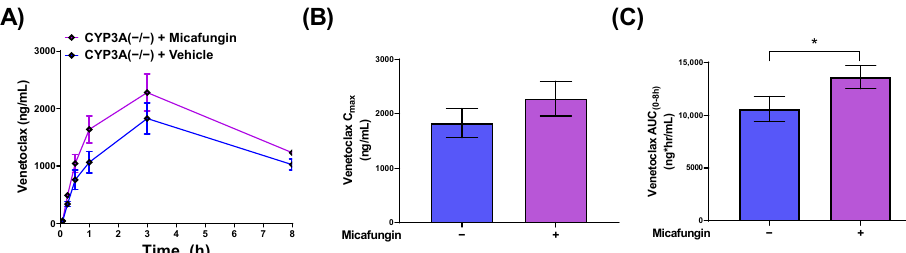
Figure 4. Micafungin-induced increases in venetoclax exposure are not mediated by CYP3A. ( A ) Plasma concentration curves of venetoclax in female CYP3A( − / − ) mice administered venetoclax (10 mg/kg; PO) 30 min after micafungin (100 mg/kg; IV) or vehicle (PBS; IV) ( n = 5/group). Serial plasma samples were collected from each mouse and analyzed via LC-MS/MS. ( B ) Maximum concentration (C max ) and ( C ) area under the concentration-time curve (AUC) using the last observed timepoint (AUC 0–8h ) calculated with non-compartmental analysis (NCA) using Phoenix WinNonlin 8.1. * p < 0.05.